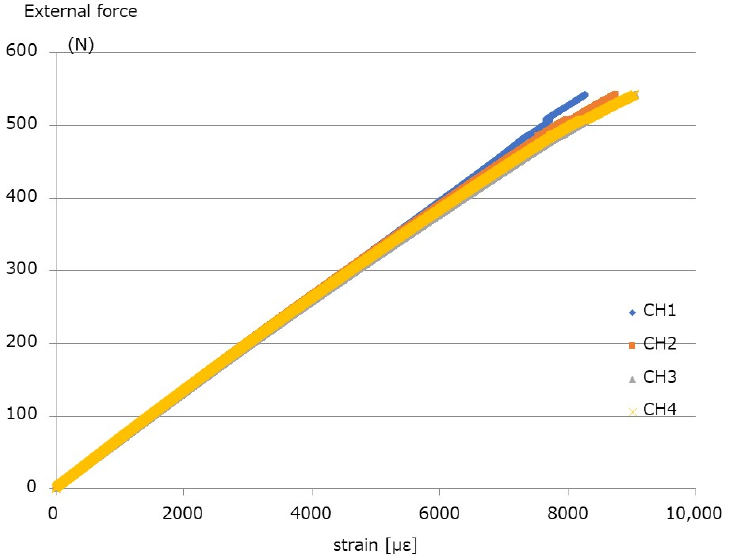
Figure 6. External force–strain curve of System 4. The CH number corresponds to the number shown in Figure 2.